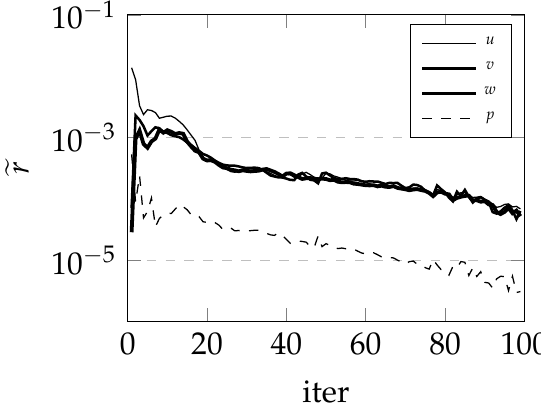
Figure 21. Convergence characteristics of flow equations.